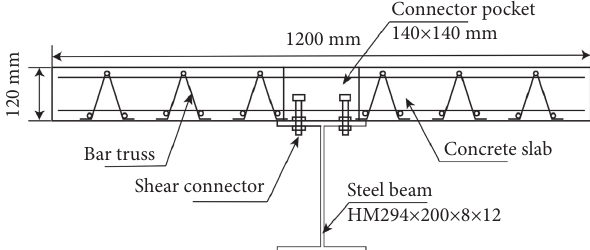
Figure 14: The cross section of the composite beams tested by Du et al.